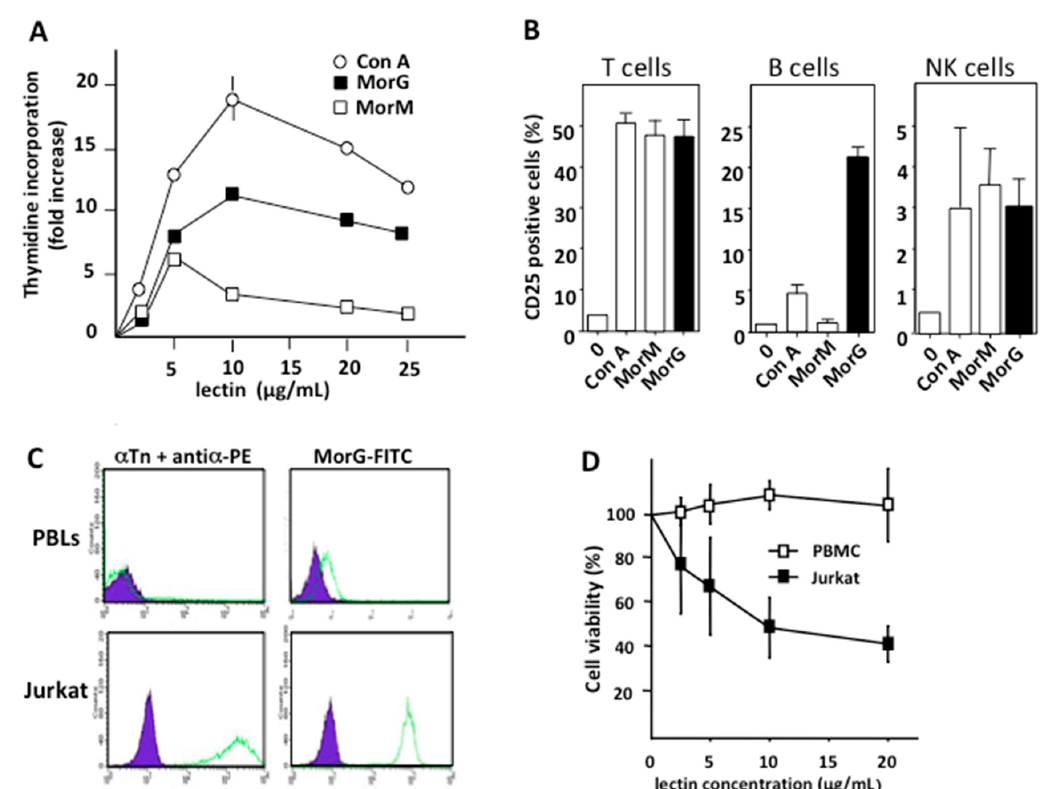
Figure 1. Morniga-G activates healthy human lymphocytes and induces cell death in leukemia cells. PBMCs from healthy donors were cultured for 3 days: ( A ) in the presence of increasing concentrations of Morniga-M (MorM), Morniga-G (MorG), and Con A and proliferative index (from the [ 3 H]-thymidine incorporation) was calculated; and ( B ) in the presence of lectins at concentrations triggering maximal proliferation. CD25 expression was evaluated using flow cytometry, in CD3+ T lymphocytes, in CD19+ CD3- B lymphocytes, and in CD56+ CD3- NK lymphocytes. Values are means ± SD of three experiments performed with three to four different healthy donors. ( C ) Resting PBMCs and Jurkat A3 leukemic cells were incubated with anti-Tn mouse monoclonal antibody + PE-conjugated anti-mouse antibody ( α Tn + anti α -PE) or FITC-conjugated Morniga G (MorG-FITC) and analyzed using cytofluorimetry. Healthy peripheral lymphocytes (PBLs) were analyzed in a gate corresponding to lymphocytes as defined by the size and granularity parameters. Autofluorescence: purple histograms, dashed green histogram: fluorescent positive cells. ( D ) PBMCs of healthy donors and Jurkat A3 leukemic cells were cultured for 24 h with different concentrations of MorG, then cell viability was evaluated in 3-(4,5-dimethylthiazol)-2-5-diphenyl terazolium bromide MTT reduction assays (mean values ± SD of four independent experiments).